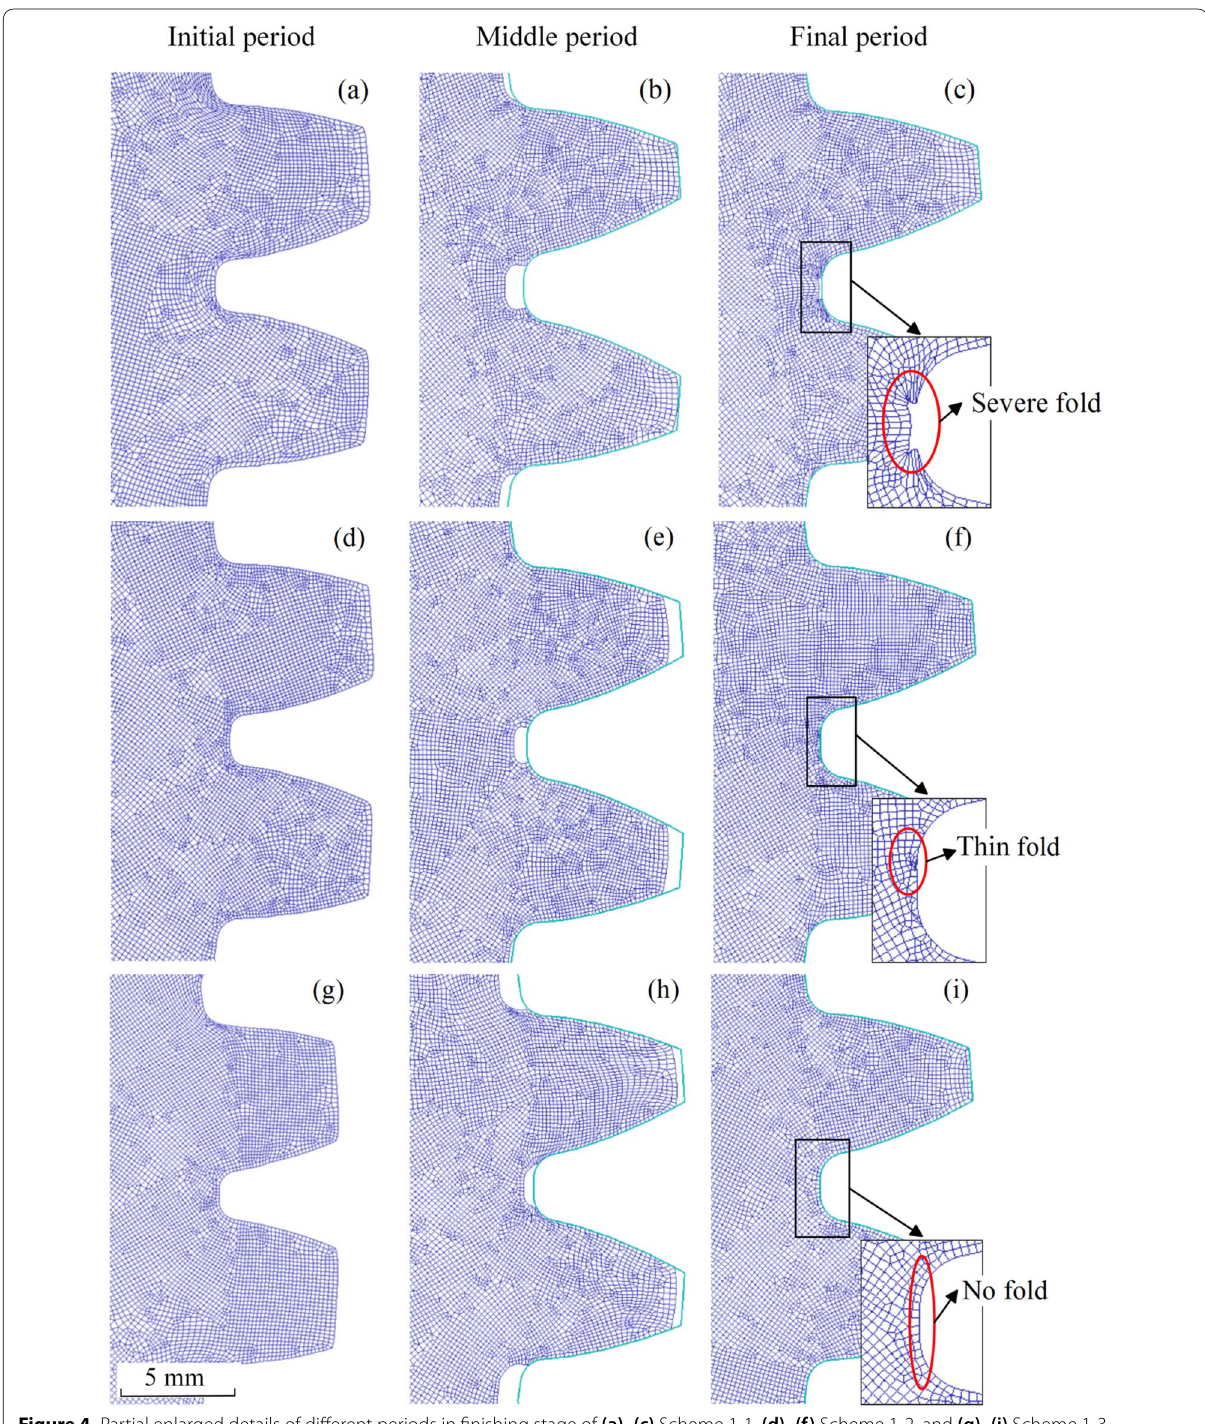
Figure 4 Partial enlarged details of different periods in finishing stage of (a) ‒ (c) Scheme 1-1, (d) ‒ (f) Scheme 1-2, and (g) ‒ (i) Scheme